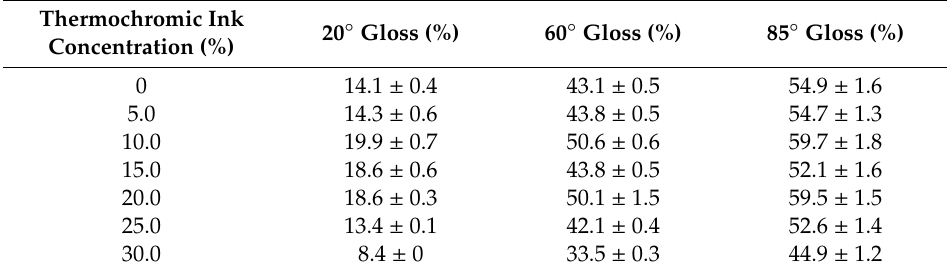
Table 2. E ff ect of thermochromic ink concentration on the gloss of finish film.